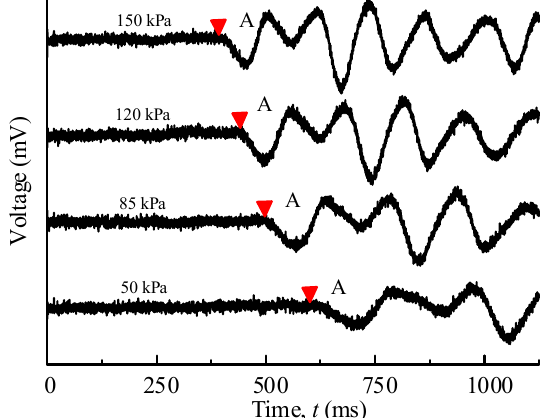
Figure 3. Typical time histories of output signals from bender element tests.